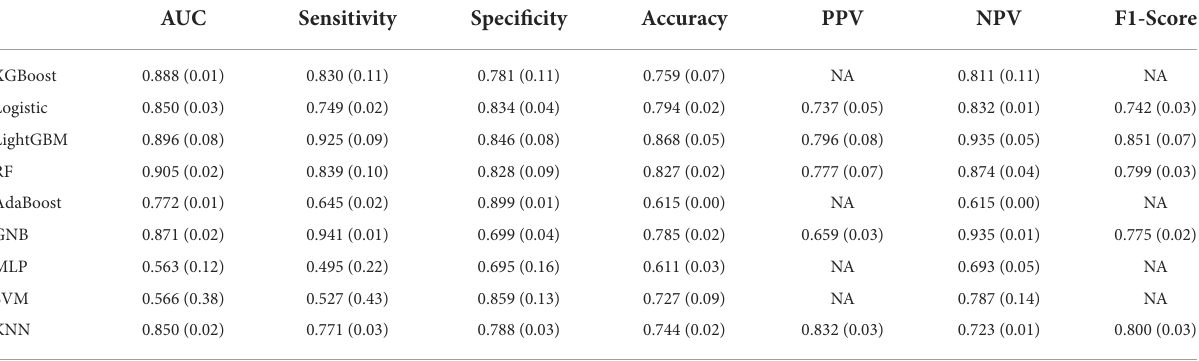
TABLE 3 Model parameters in training set.